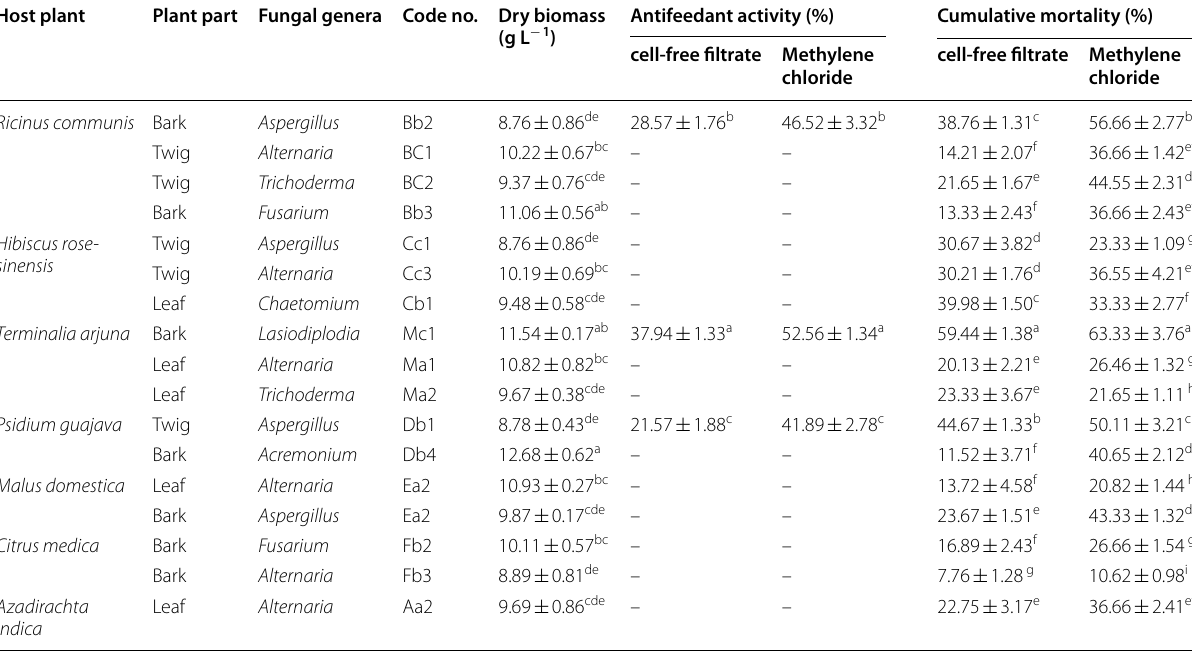
Table 1 Host plants, isolated endophytic fungal genera, antifeedant activity (%), and cumulative mortality (%) of their cell‑free filtrate and methylene chloride